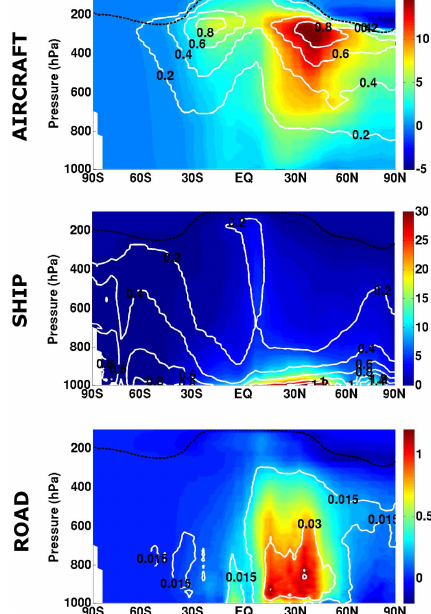
Fig. 4. Zonal mean perturbations of OH (10 3 molecule cm − 3 ) dur- ing July for the 2050 A1B scenario due to a 5% perturbation of aircraft emissions (top), ship emissions (middle), and road traffic emissions (bottom). Solid white contour lines show the percentage change relative to the BASE simulation while the dashed black line indicates the tropopause. Note that different scales have been used for each of the traffic sectors and that the scales have been reversed in order to show OH reductions, arising from a 5% decrease in emissions, as positive